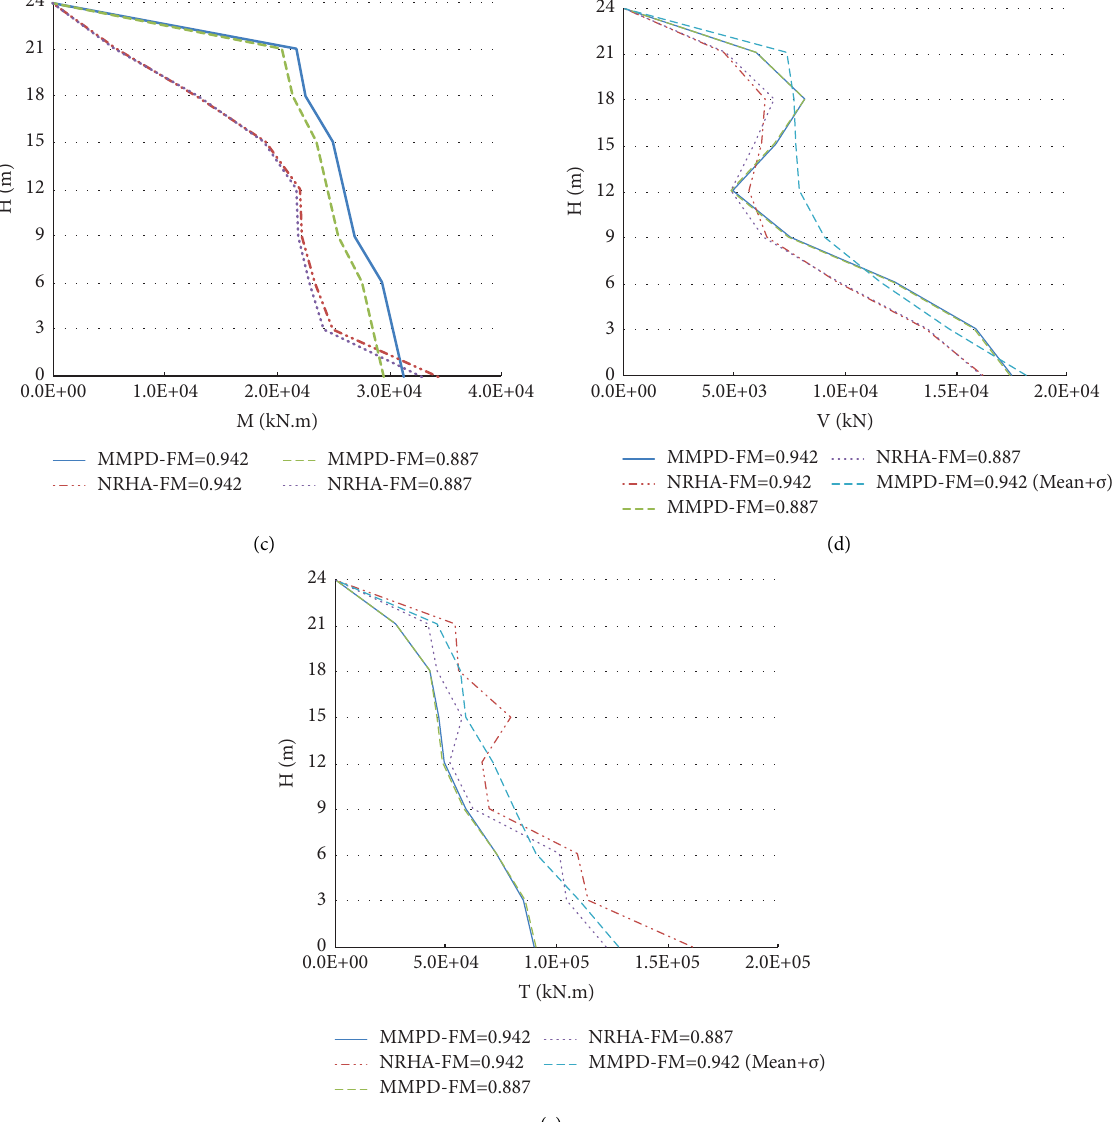
Figure 14: Building B1 under BORREGO record with diferent distributions of reinforcements: (a) comparison between NRHA and interstorey drifts limit, (b) NRHA fexural moment demands and MMPD fexuralcapacities of 30cm wall, (c) NRHA fexural moment demands and MMPD fexural capacities of 20cm wall, (d) NRHA/approximated MMPD shear demands, and (e) NRHA/approximated MMPD torsional